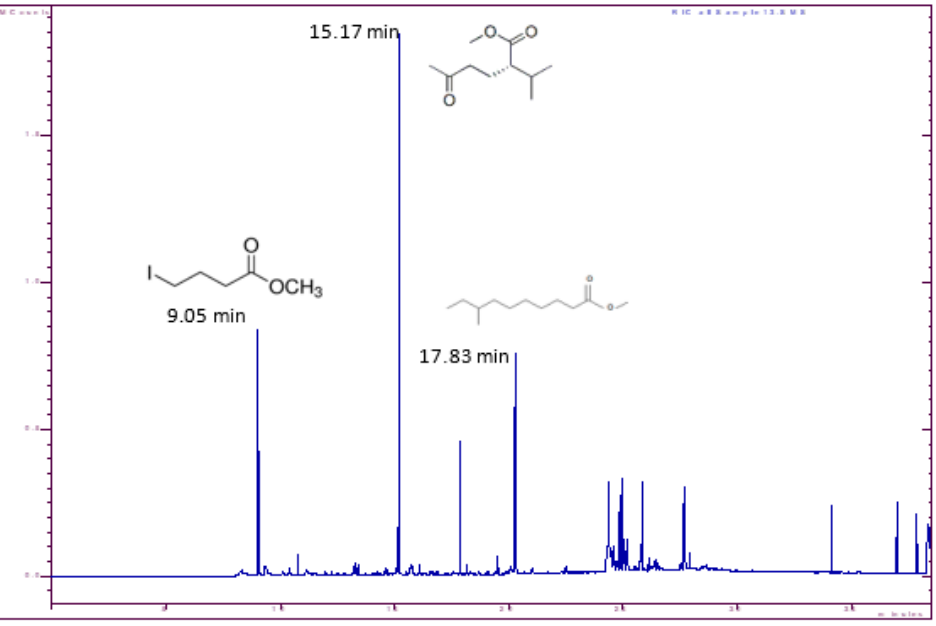
Figure 13. Gas chromatography–mass spectrometry chromatogram of PHB extracted from E. aquimaris shows three monomeric compositions of PHB; Butanoic acid, 4-Iodo-, methyl ester; Hexanoic acid, 2-(1-methylethyl)-5-oxo-, methyl ester; and Decanoic acid, 8-methyl-, methyl ester.